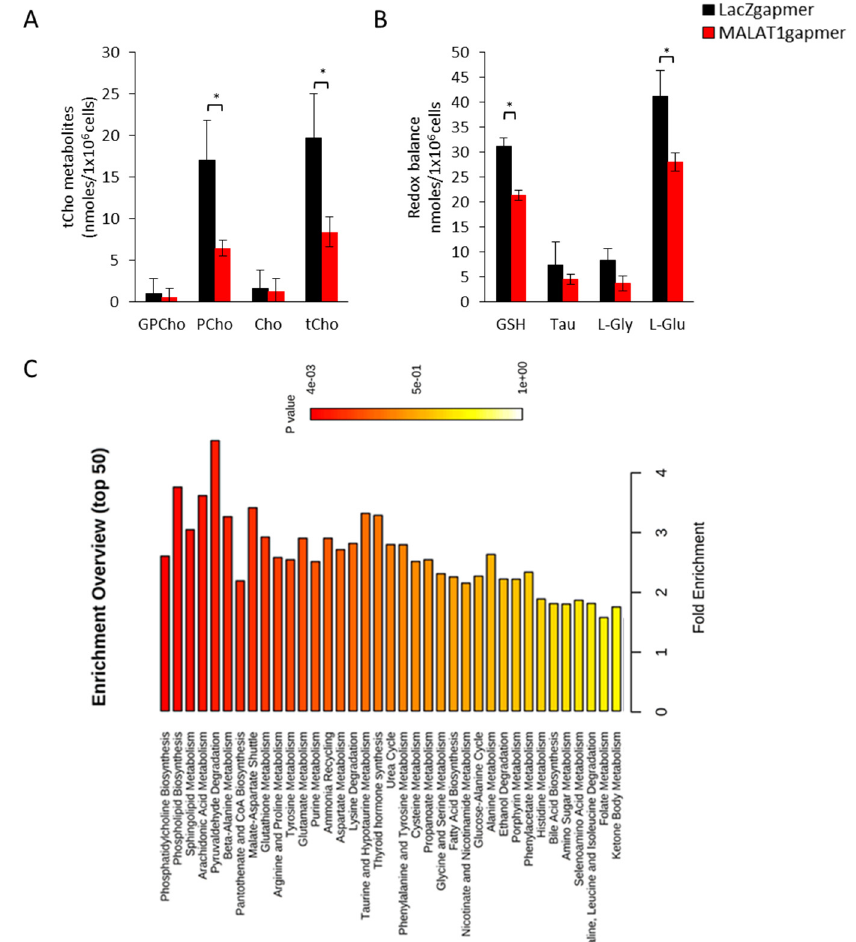
Figure 1. Metabolomic analysis in MALAT1-depleted PCa cell lines: ( A , B ) Quantitative H-1NMR spectroscopy of Phosphatidylcholine metabolites in MALAT1-depleted and LacZ control PCa cells. Phosphatidylcholine metabolites (choline, Cho; phosphocholine, PCho; glycerophosphocholine, GPC, ( A ) and Redox Balance metabolism (GSH, Glutathione; Tau, Taurine; L-Gly, L-Glycine; L-Glu, L-Glutamic acid, ( B ) are expressed as mean ± SEM (N = 3). * p < 0.05 vs. gapmer LacZ. ( C ) Quantitative Enrichment Analysis of the biologically meaningful patterns significantly altered the whole metabolome obtained by quantitative NMR-based spectroscopy in MALAT1-depleted vs. LacZ control cells.